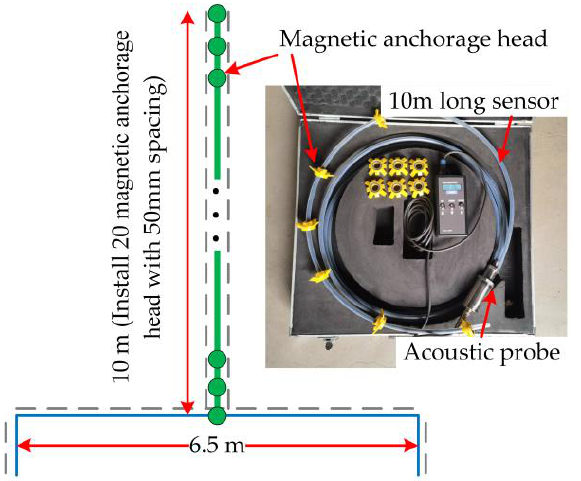
Figure 15. Schematic diagram of acoustic multipoint displacement meter equipment and roof installation.